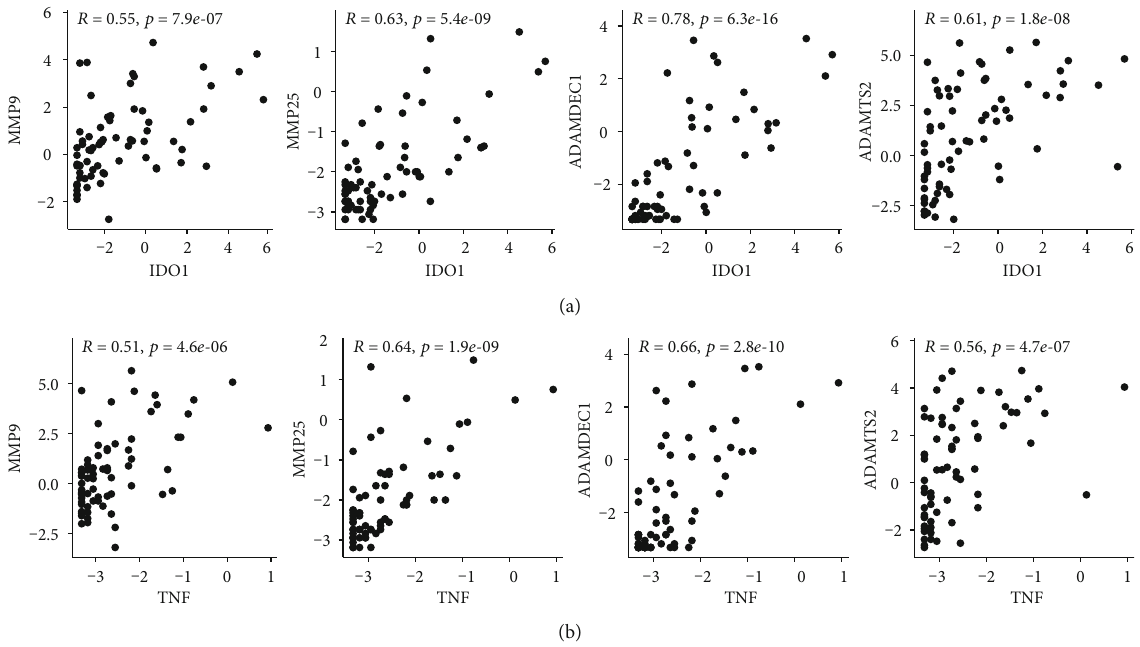
Figure 8: Correlation between IDO1 (a) or TNF (b) expression with MMP9, MMP25, ADAMDEC1, and ADAMTS2 (left to right) in the training cohort. Displayed values are log transformed ( log2 ð x + 0 : 1 Þ